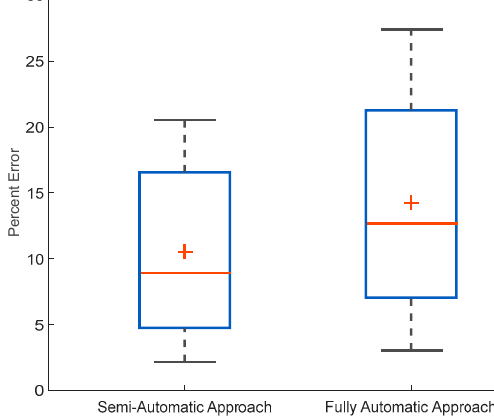
Figure 5. Distribution of mean absolute error of the chew counting algorithm for both semi- and automatic approaches.